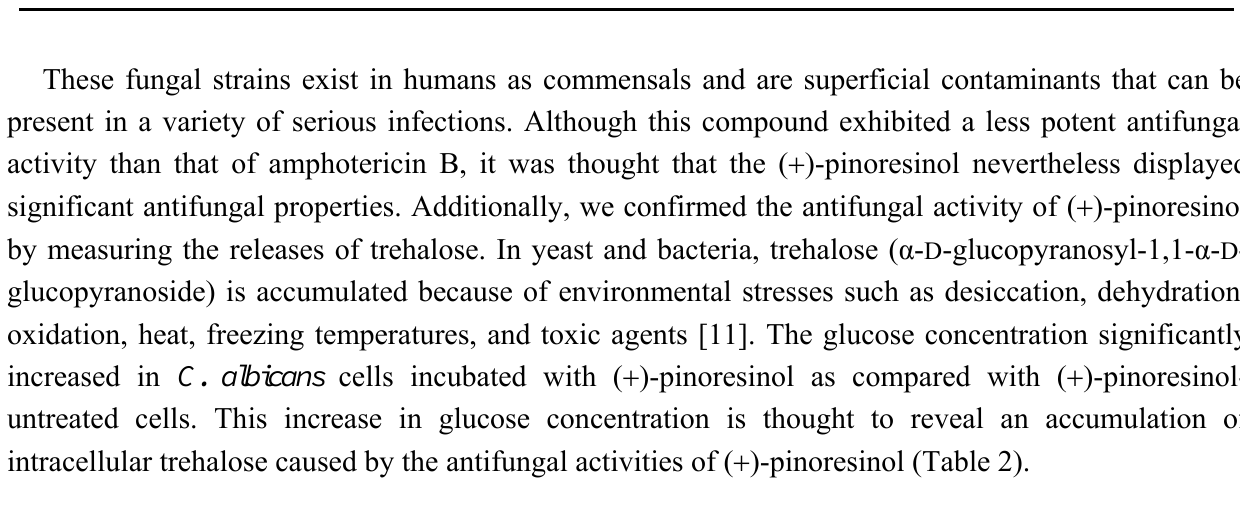
Table 2. The concentration of trehalose and glucose caused by ( + )-pinoresinol.